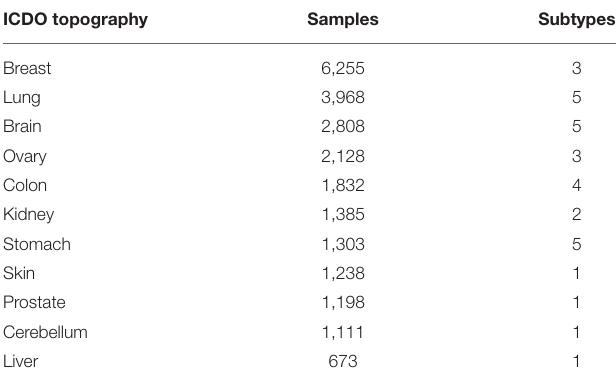
TABLE 3 | The number of samples and cancer subtypes in the studied organs. ICDO